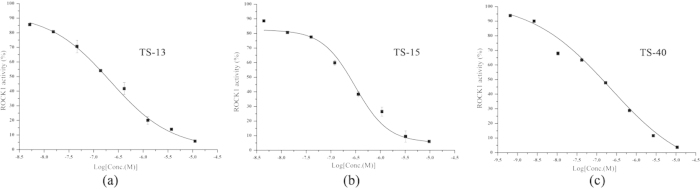
The concentration-dependent inhibition of ROCK1 activities for TS-13, TS-15 and TS-40.